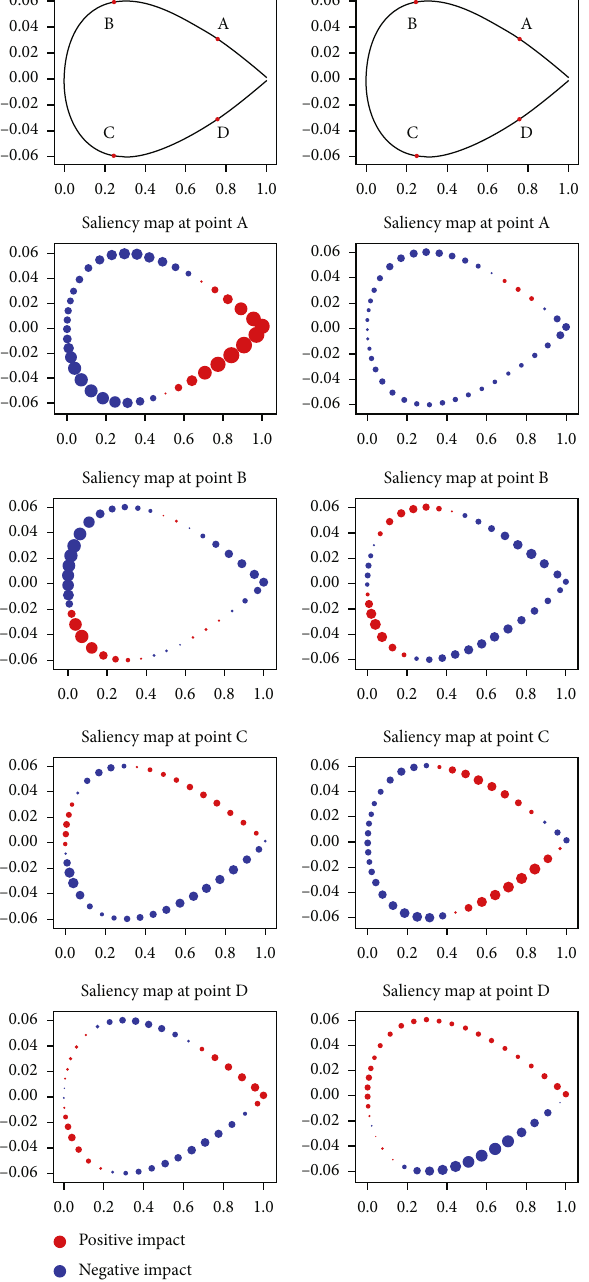
Figure 14: Saliency map at di ff erent